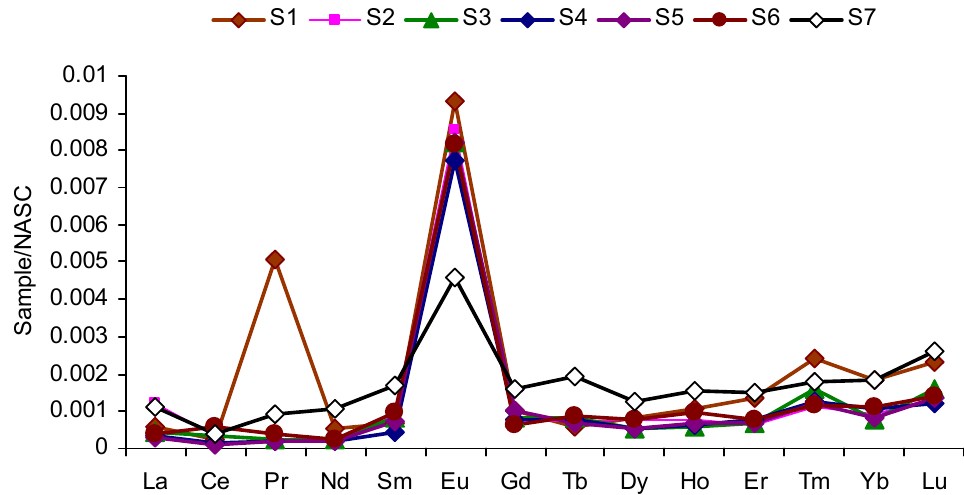
Figure 7. Normalized distribution of rare earth elements in the lake water.